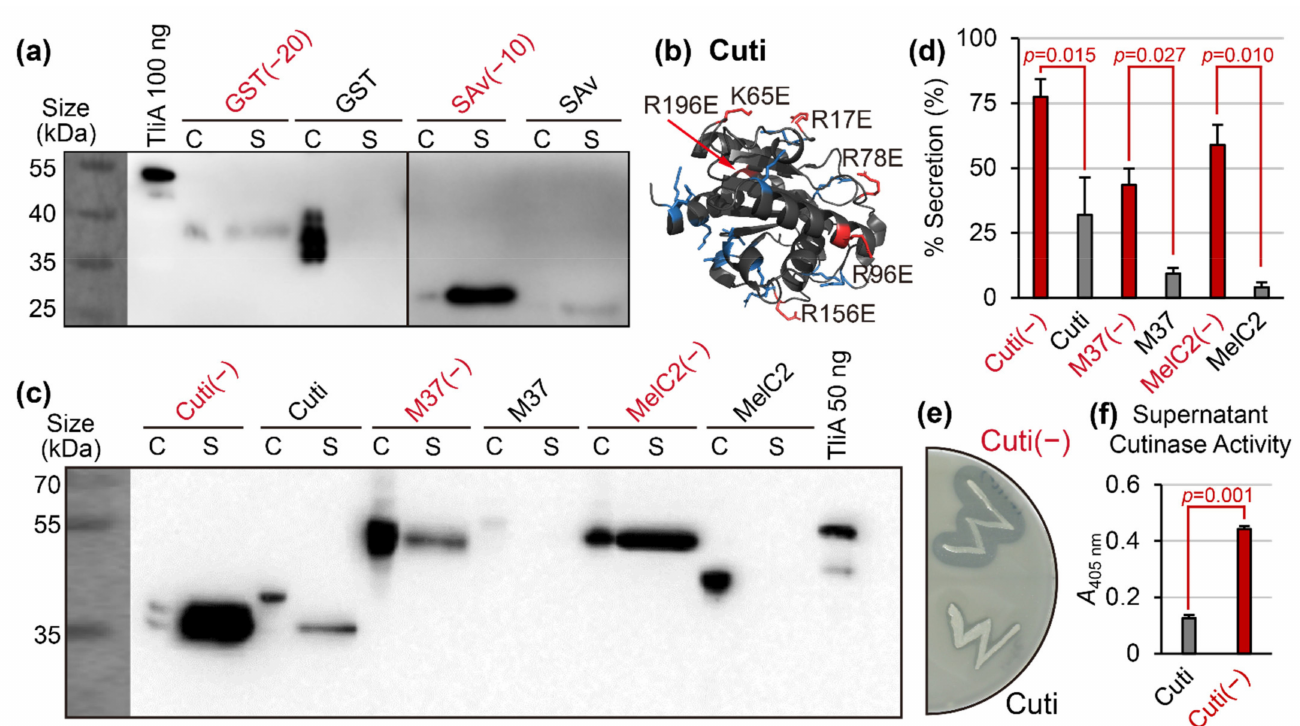
Figure 4. Secretion of negatively supercharged proteins. The liquid cultures of P. fluorescens were grown in TB for two days at 25 ◦ C. The cell pellet samples are labeled “C” while the supernatant samples are labeled “S”. A signal in “S” indicates that the sample was secreted. ( a ) Secretion enhancement in negatively supercharged versions of glutathione S-transferase (GST) and streptavidin (SAv). The negatively supercharged mutants were secreted while the wild-types were not. ( b ) The structure of N. haematococca cutinase (Cuti) (PDB ID 1cex), used for the supercharging mutation. Red color indicates the surface-exposed cationic residues with AvNAPSA value ≤ 100, which were replaced by anionic glutamates. Blue color indicates the rest of the cationic residues. ( c ) Secretion enhancement by negatively supercharged enzymes. Negatively supercharged mutants of Cuti( − ), M37( − ), and MelC2( − ) were compared with wild-type cutinase, M37 lipase, and MelC2 tyrosinase for secretion using Western blot. Note that Cuti( − ) C lane has two bands, probably corresponding to oxidized and reduced forms. ( d ) Quantification of Western blot experiment presented in panel ( c ). All three of the negatively supercharged mutants (red colors) exhibited a significant increase in secretion. Error bars represent sample standard errors. Performed on biological duplicates, n = 3. ( e ) Plate enzymatic activity assay of Cuti( − ) and Cuti. The negatively supercharged mutant Cuti( − ) colony exhibits a much larger halo, due to the increased amount of secreted enzyme. ( f ) Quantification of results in panel ( e ). Cell culture supernatant cutinase activity was measured with the pNPB